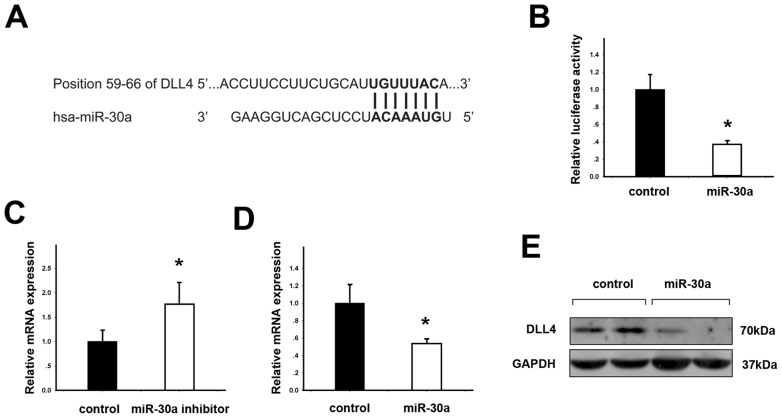
DLL4 is a direct target of miR-30a.(A) Putative complementary site of DLL4 mRNA 3′-UTR for the seed region of miR-30a identified by prediction programs. (B) Endothelial HUVEC-C cells were transfected with DLL4 3′-UTR vector and miR-30a vector or negative control vector (pcDNA3.0) for 48 hours. Relative luciferase activities of DLL4 3′-UTR vector was reduced by miR-30a. (C) HUVEC-C cells were transfected with miR-30a inhibitor or negative control (scramble miRNA) for 24 hours. Relative mRNA expression of DLL4 was increased by miR-30a inhibitor. (D) HUVEC-C cells were transfected with miR-30a or negative control (pcDNA3.0) for 24 hours. Relative mRNA expression of DLL4 was decreased by miR-30a. (E) Western blotting showed that DLL4 was decreased by miR-30a after 48 hours of transfection. Data are represented as the means ± standard errors of the means (SEM). *statistics significant.